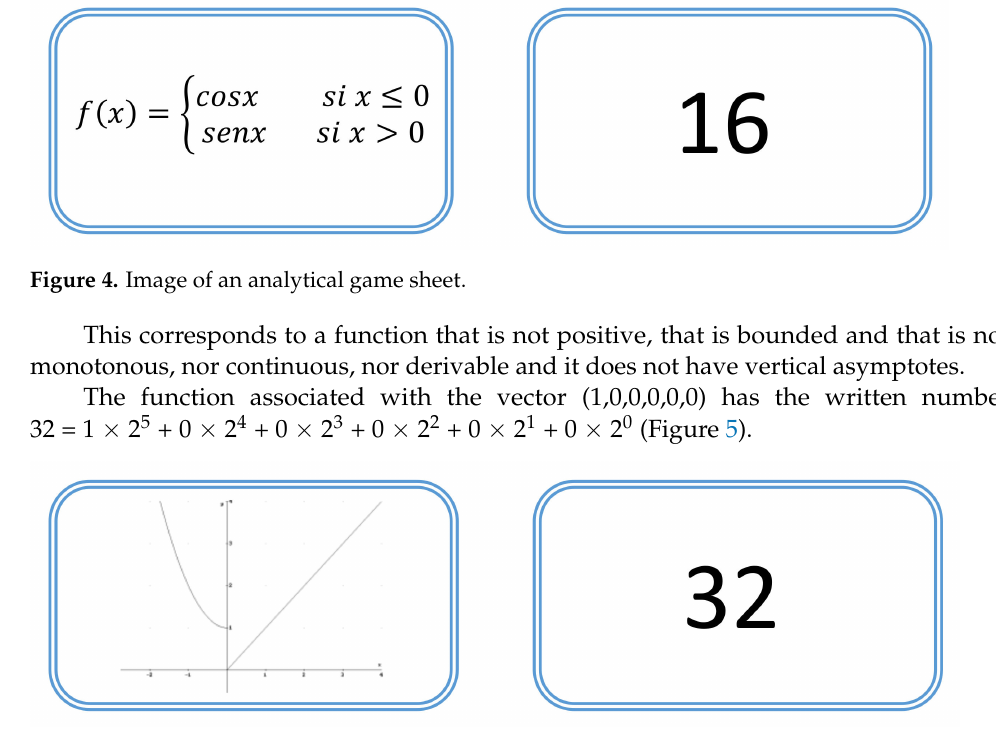
Figure 5. Image of a graphic card of the game.